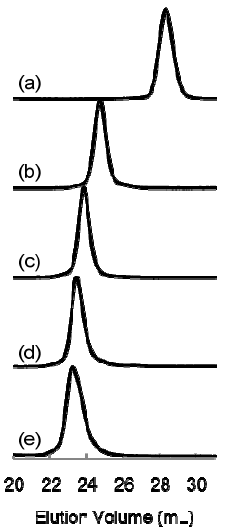
octablock; and ( e ) (AB) 4